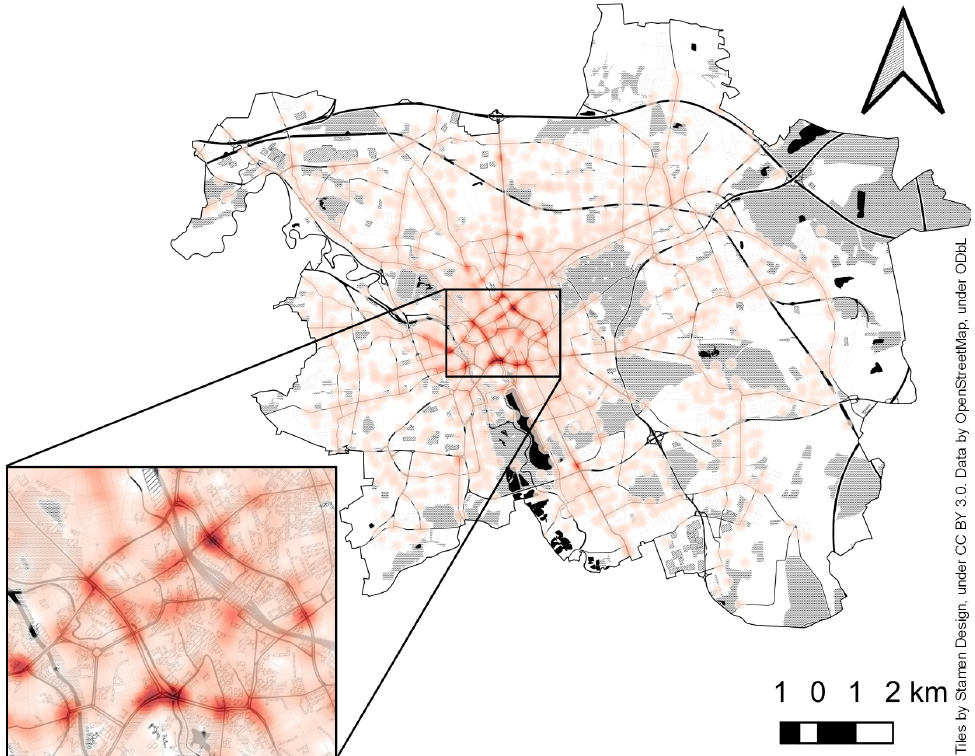
Figure 1. Heatmap of all listed accidents involving cyclists from 2017 to 2020 in Hanover